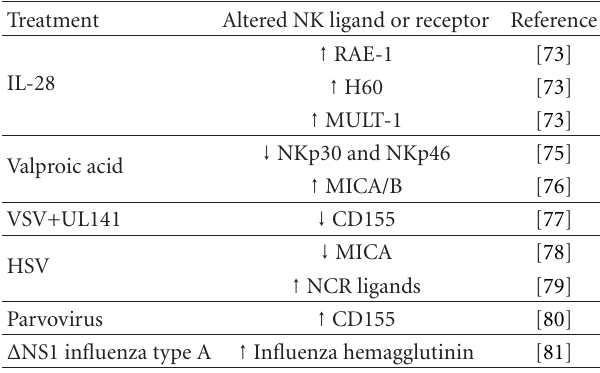
Table 1: Relevant NK receptor-ligand interactions in the field of